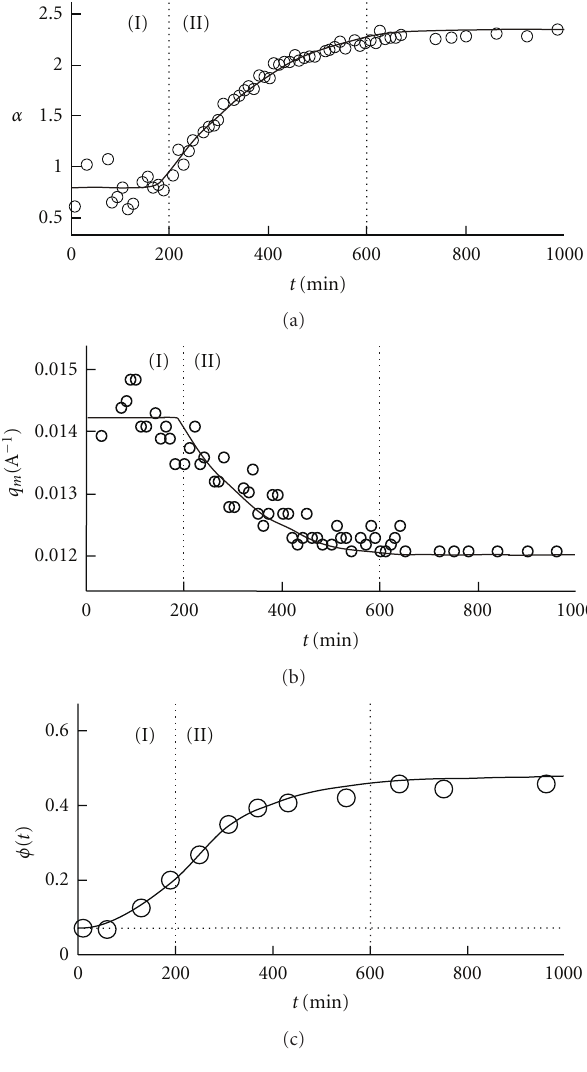
Figure 7: A power law exponent ( α ), q -position of scattering maxi- ma ( q m ), and a volume ratio of microcrystals covered by PS φ ( t ), determined as a function of polymerization time ( t